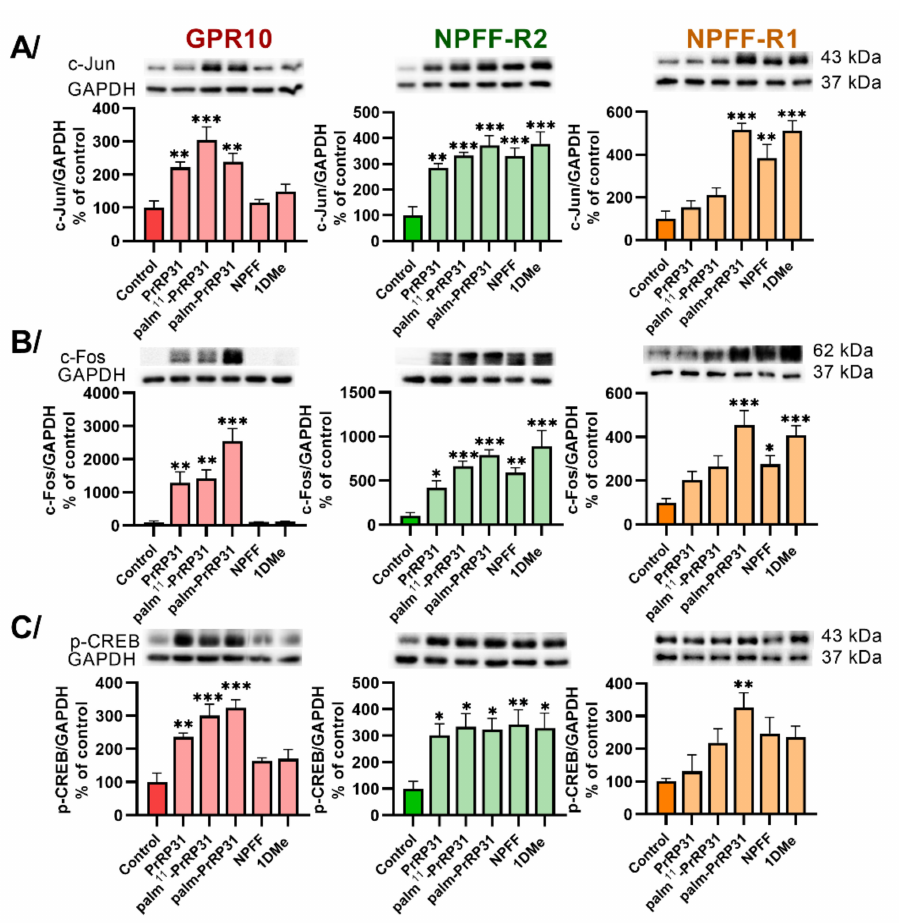
Figure 5. Activation of ( A ) c-Jun and ( B ) c-Fos after 60 min incubation and induction of ( C ) CREB phosphorylation after 5 min incubation at 37 ◦ C with peptides in final concentrations 10 − 6 M in CHO-K1 cells expressing receptors GPR10, NPFF-R2 and NPFF-R1. Densitometric quantification was normalized to GAPDH and the phosphorylation level in the untreated control was standardized as 100%. Data are presented as mean ± SEM and analyzed by two-way ANOVA followed by Dunnett’s post hoc test. Experiments were performed independently at least three times. Statistically significant differences from the control are indicated (* p < 0.05, ** p < 0.01, *** p <